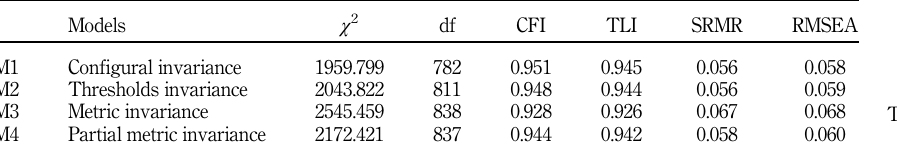
Table 3. Test of measurement